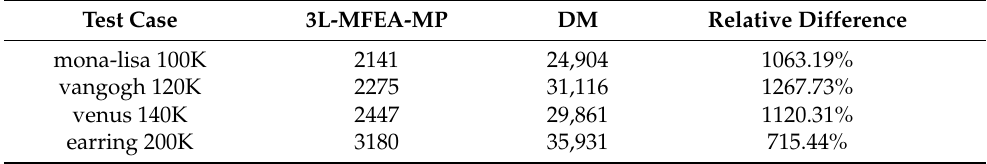
Table 7. Real engraving machine operation